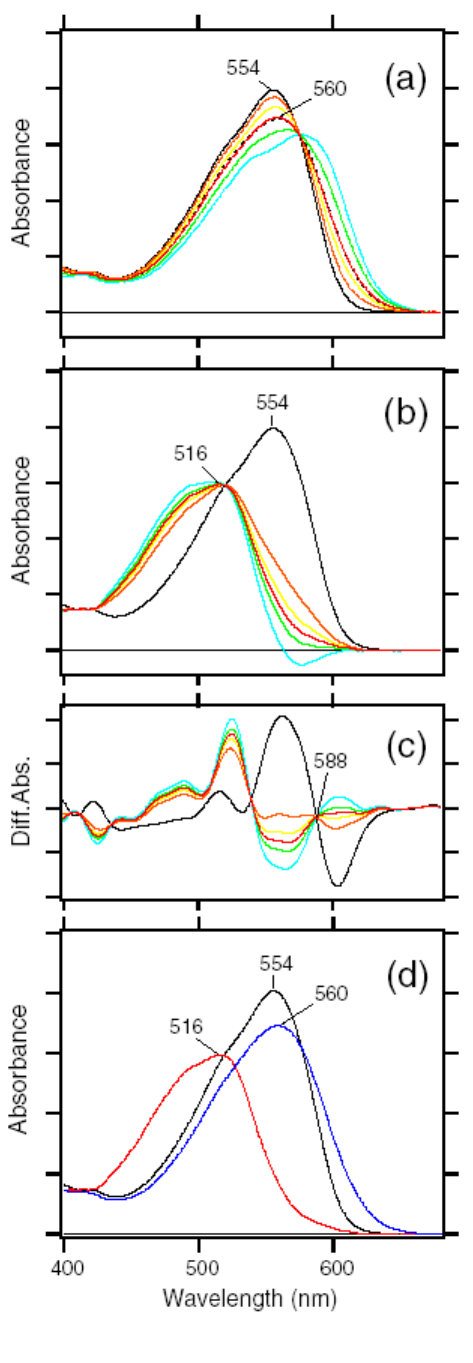
Figure 24. Determination of the absorption spectra of the K and L intermediates of ASR at 170 K. (a,b) Black solid line represents absorption spectrum of ASR Second derivatives of absorption spectra in Figure 24b, where the corresponding spectra are shown by the same color. (d). Absorption spectra of ASR (blue line) and the L intermediate (red line) at 170 K. The spectra of the K and L intermediates are reproduced from the red spectra in Figure 24a and b, respectively. One division of the y-axis corresponds to 0.1 (a,b,d) and 0.0002 (c) absorbance units. These figures are reprinted with permission from Kawanabe et al. [71]. Copyright 2007 American Chemical